Question: What visual encoding does this figure use to show its data?
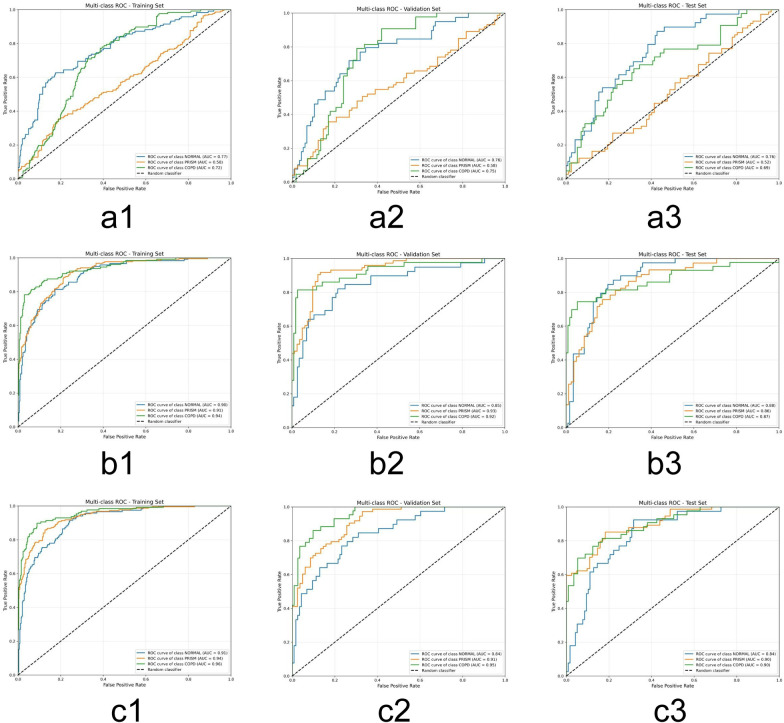
Answer: line